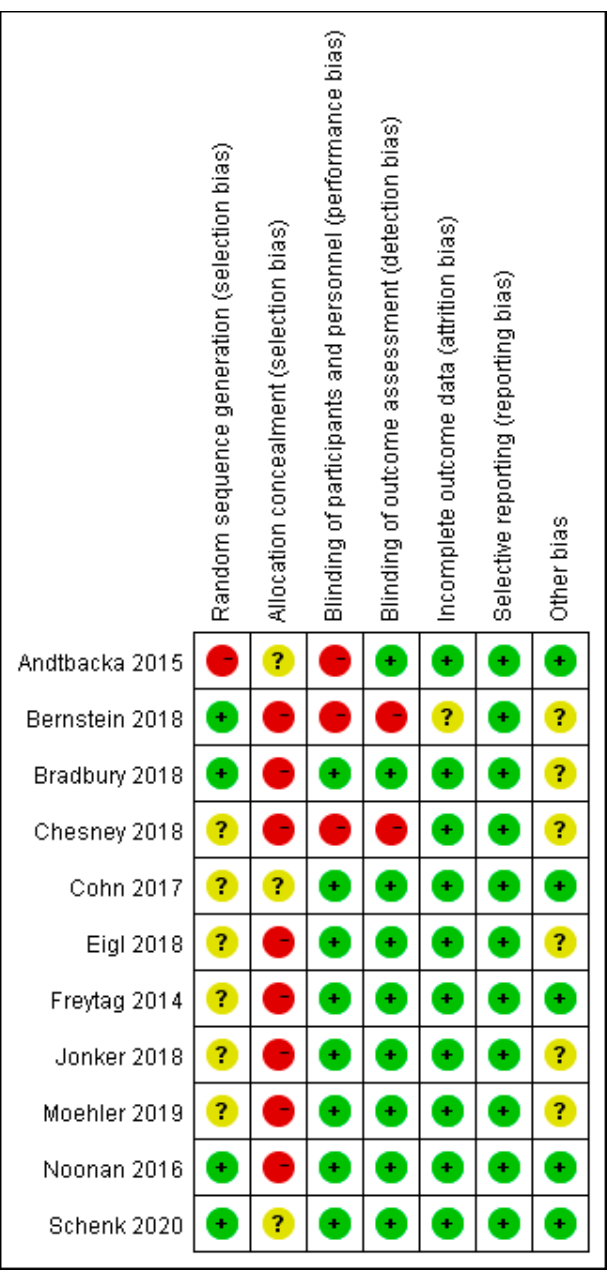
Figure 2. Assessment of risk of bias for 11 included randomized controlled trials.